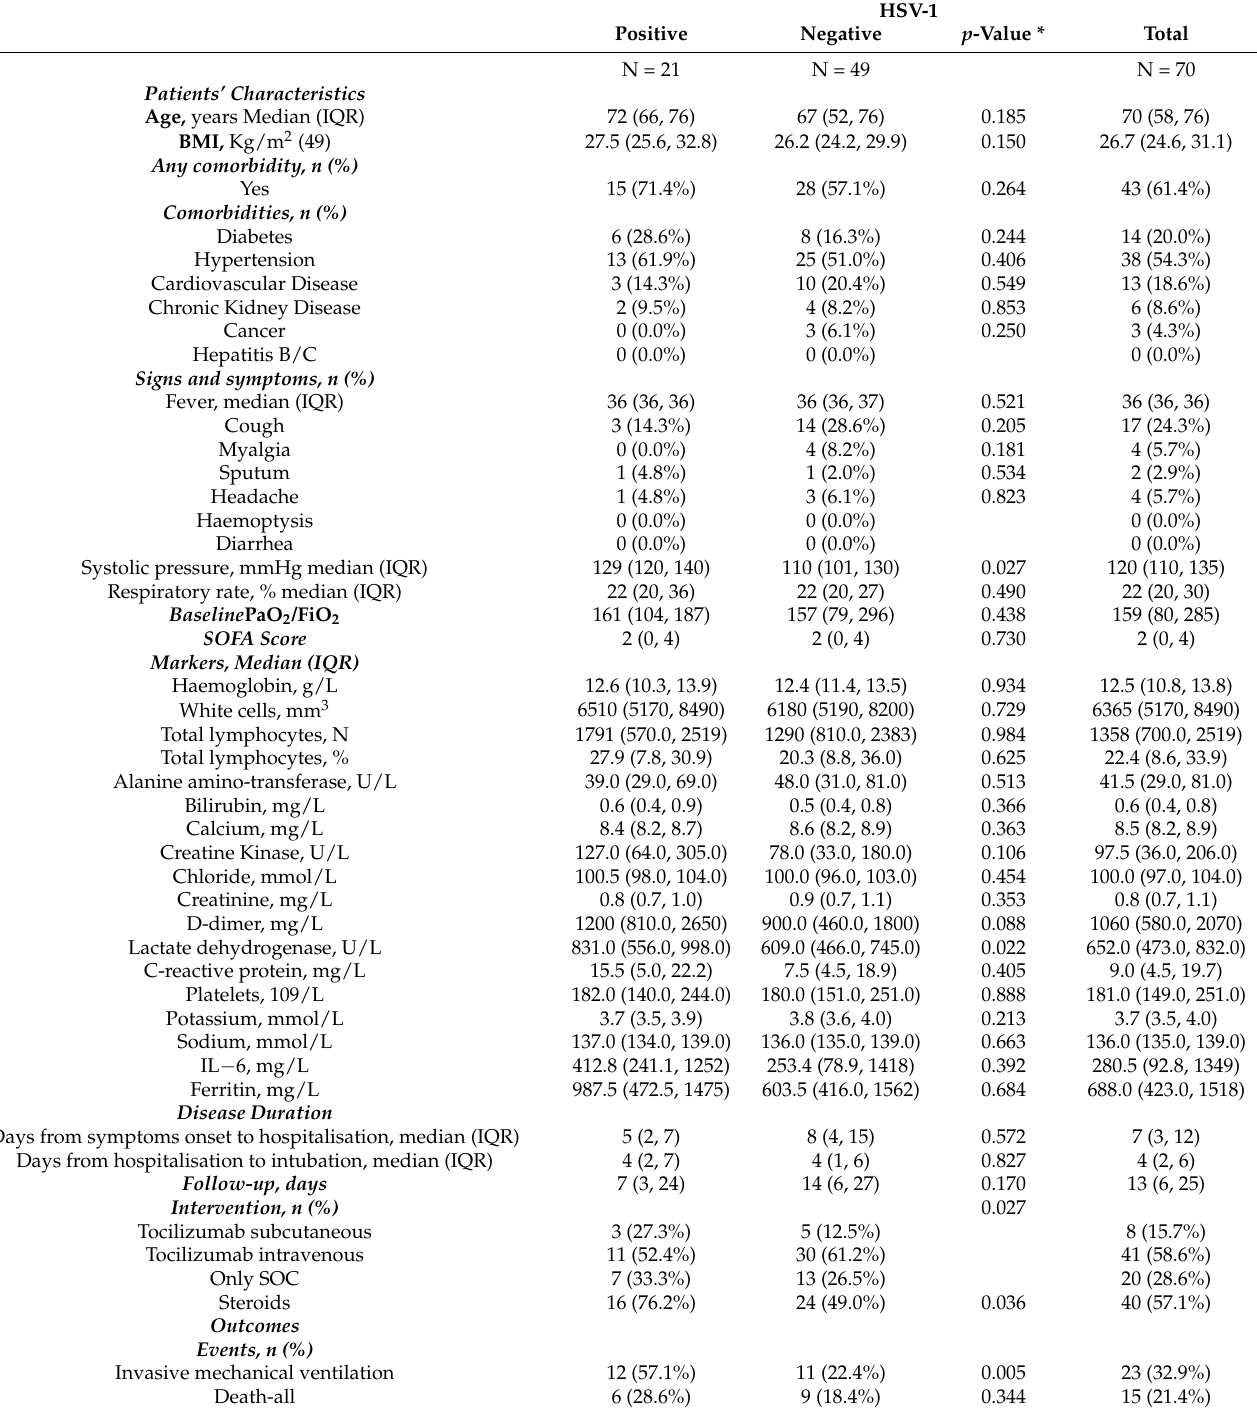
Table 1. Baseline characteristics, comorbidities and outcome of COVID-19 patients by HSV-1